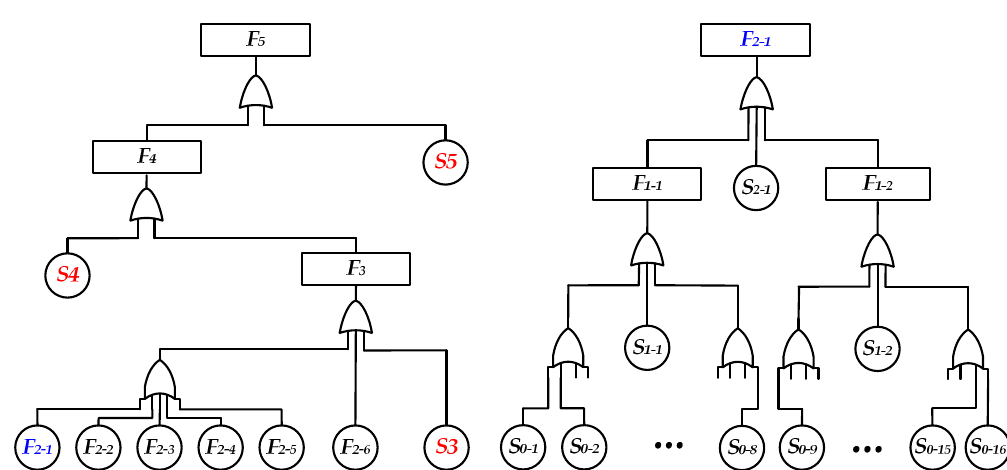
Figure 3. Fault-tree diagram of the tool (part).